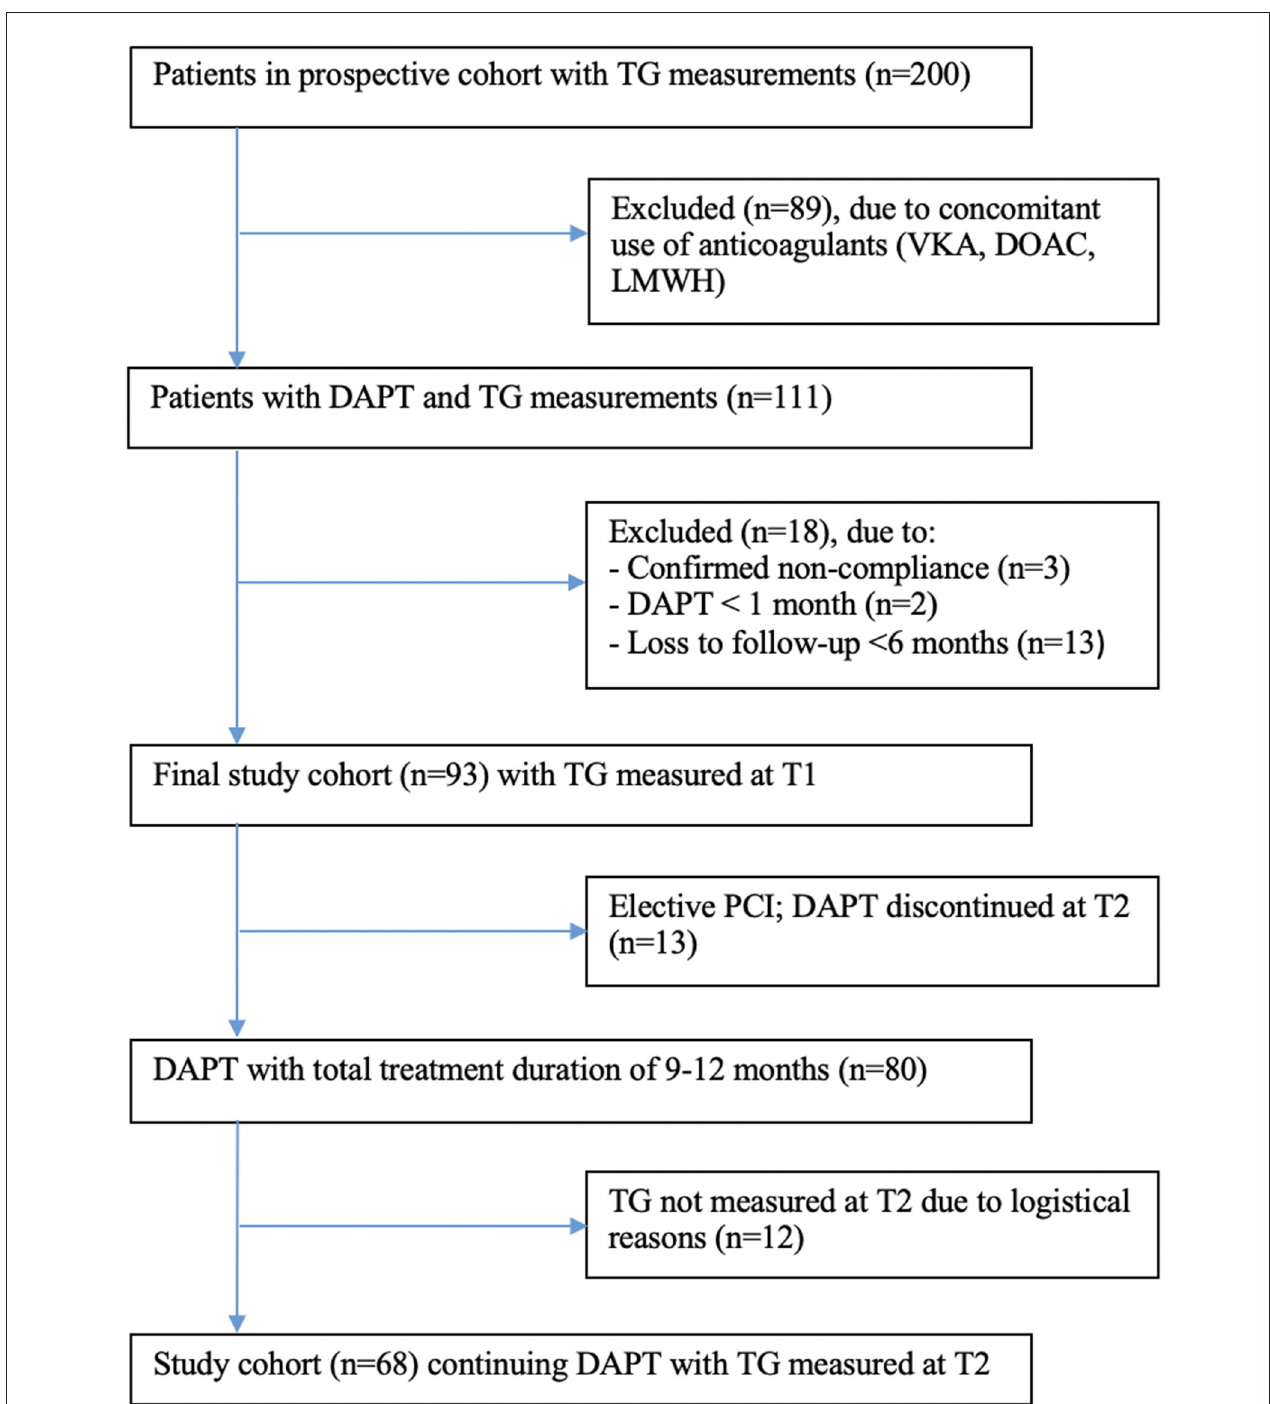
FIGURE 2 | Flow diagram of study inclusion and follow-up. TG, thrombin generation; VKA, vitamin K antagonist; DOAC, direct-acting oral anticoagulants; LMWH, low molecular weight heparin; DAFT, dual antiplatelet therapy; PCI, percutaneous coronary intervention.